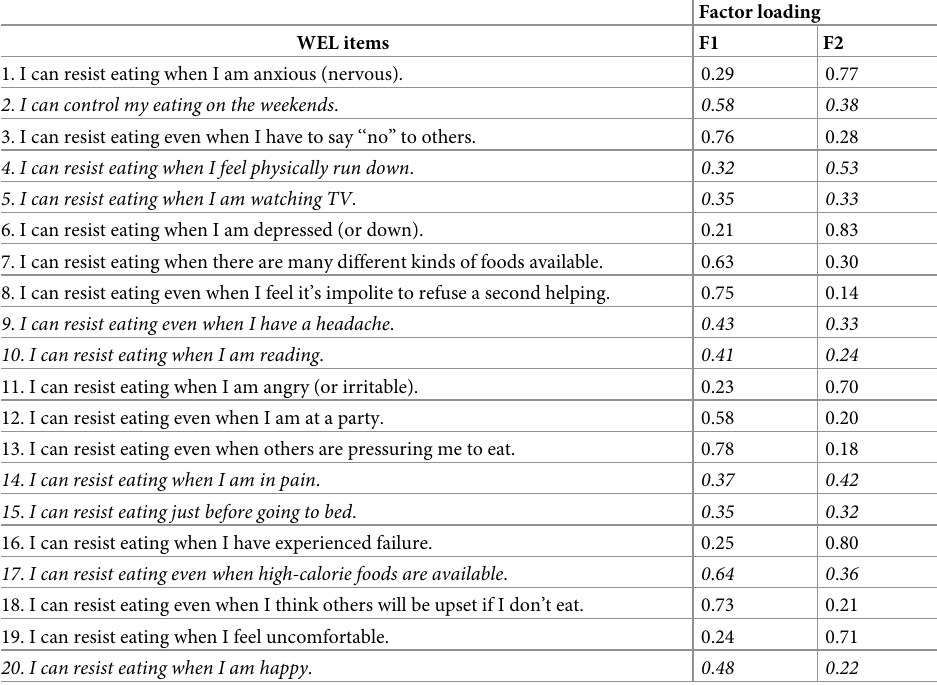
Table 7. Exploratory factor analysis results of the French version of the weight efficacy Life-Style questionnaire, carried out on the clinical sample (n =